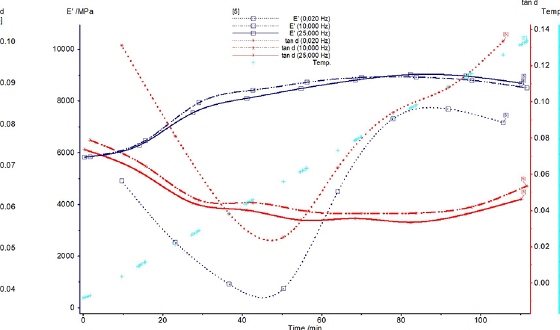
Figure 5. Mechanical spectroscopy of Cedrela sp . up to 200°C.